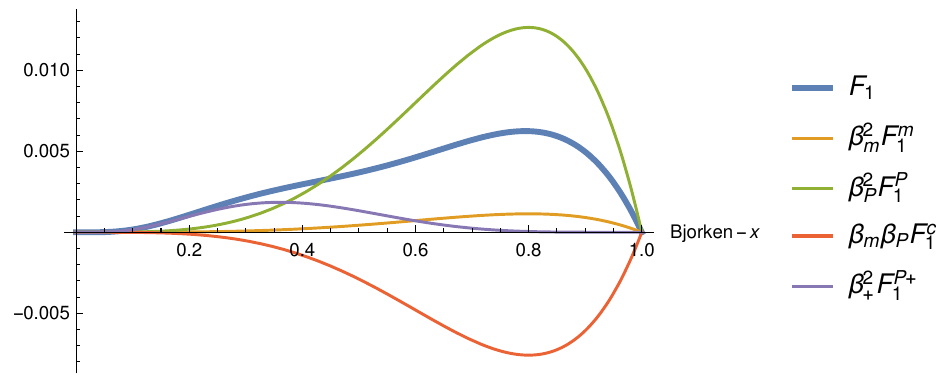
Figure 3 . The full structure function F 1 (blue line) as a function of the Bjorken parameter x , obtained from the contribution of the twist-3 spin-1/2 fermionic operator the contributions from the minimal coupling β 2 where the intermediate state λ X line); the contribution from crossed terms β m β P F c interaction β 2 F P + + 1